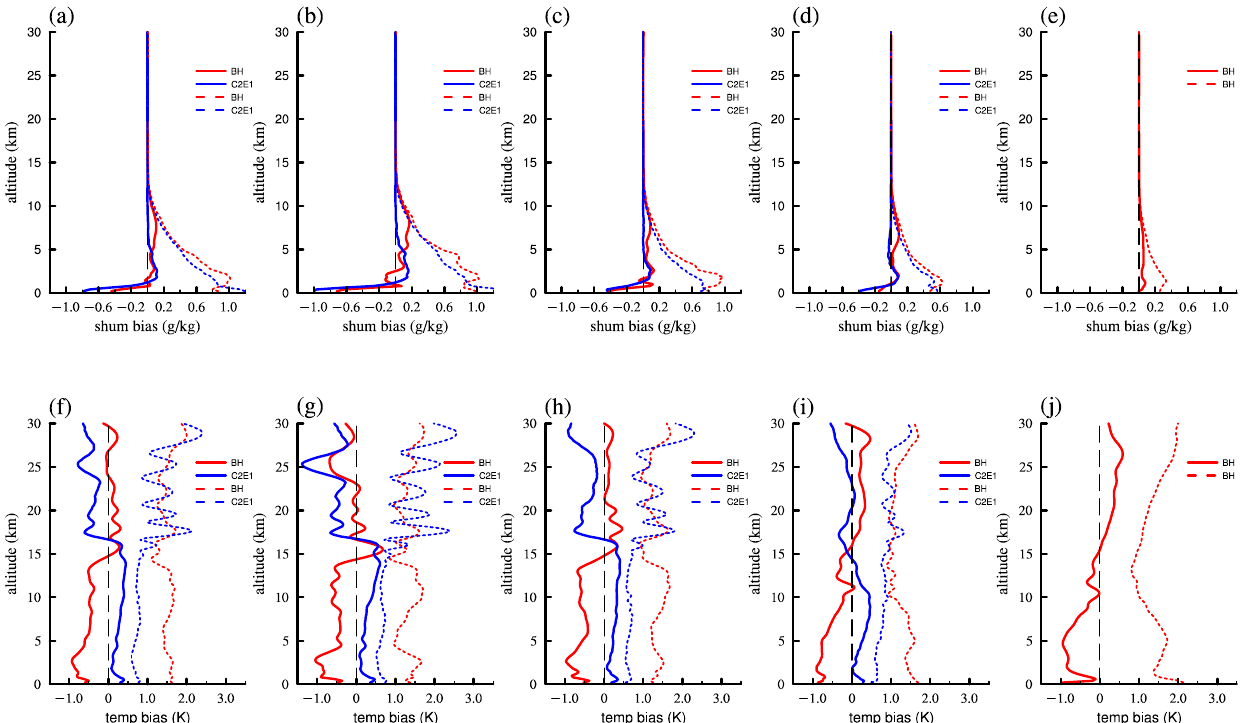
Figure 8. Vertical profiles of the average specific humidity bias, temperature and STD for the BH and C2E1 data at different latitudes. ( a – e ) The average specific humidity bias and STD (top; units: g/kg) in the range of 0–45 ◦ , 0–15 ◦ , 15–30 ◦ , 30–45 ◦ , and 45–90 ◦ , respectively; ( f – j ) same as ( a – e ) but for the temperature (bottom, units: K). The red and blue solid (dashed) lines indicate bias (STD) values of BH and C2E1 data, respectively.